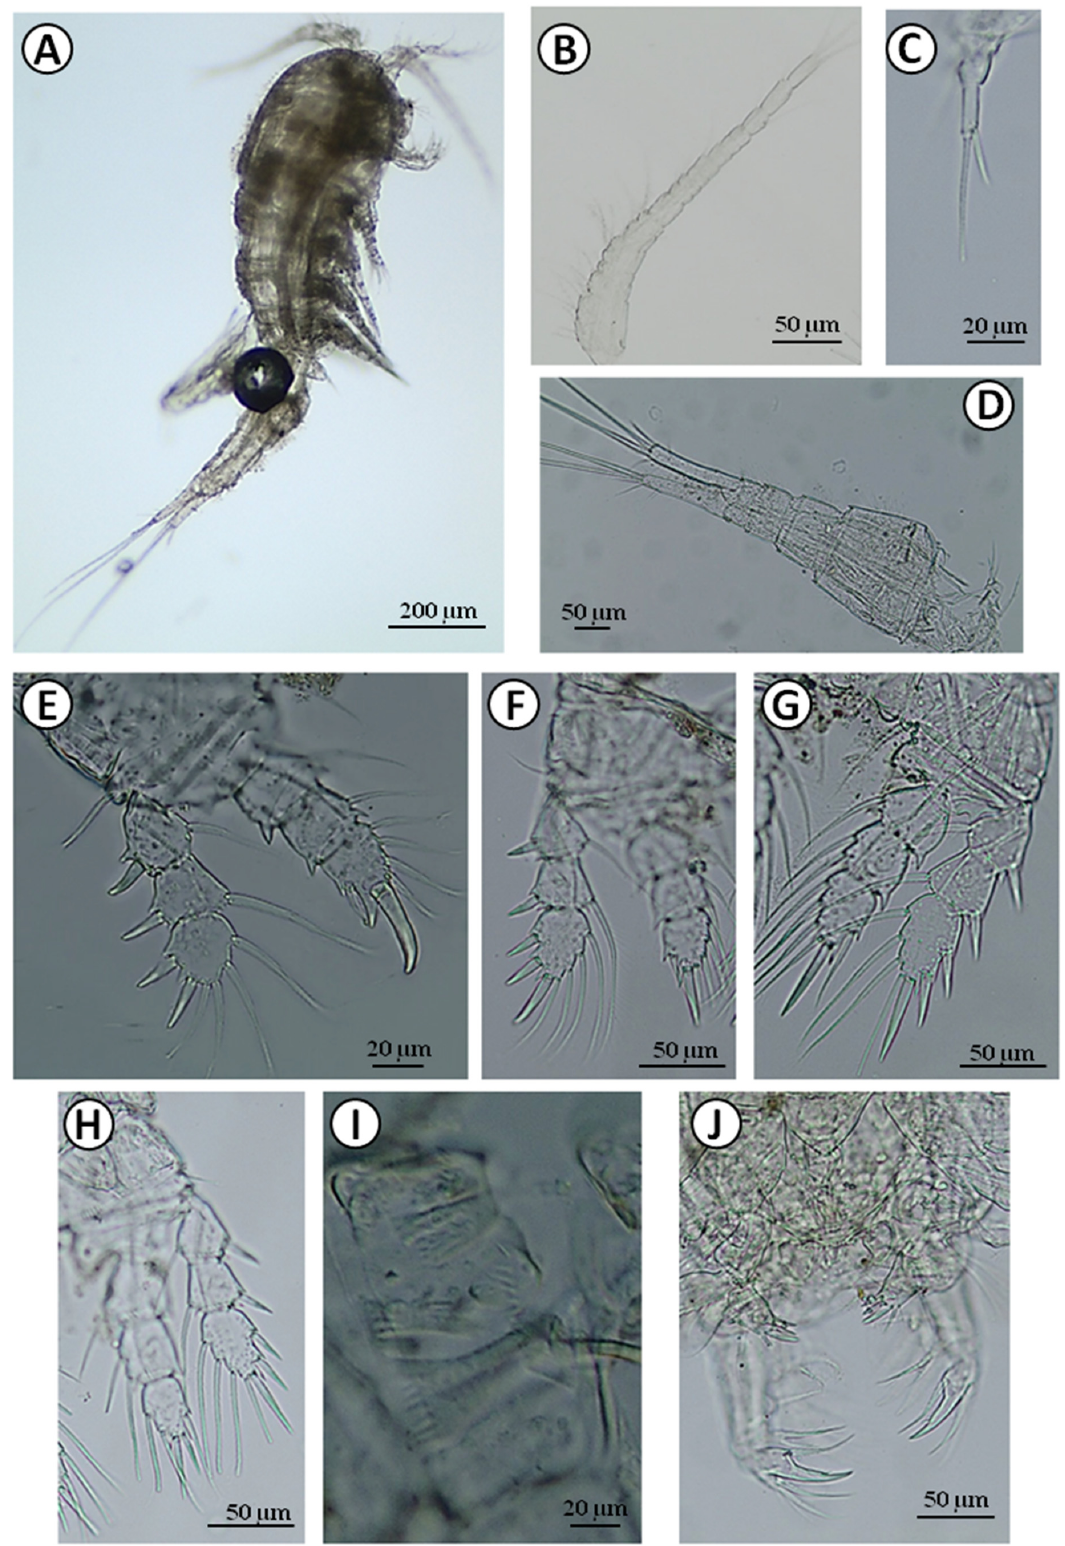
Figure 5. Diacyclops bisetosus : A —body; B —antennule; C —P5; D —furcal branches; E —P1; F —P2; G —P3; H —P4; I —coxopodite of P4; J— mouthparts.